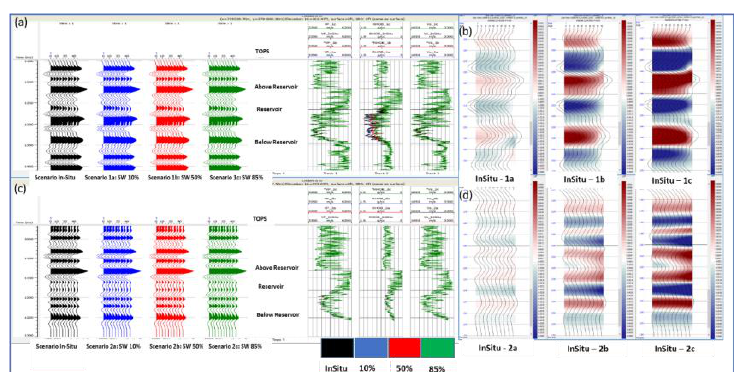
Figure 2. ( a ) Gas production well with different water saturation scenarios—angle of synthetic gath- ers with corresponding log tracks ( b ) Gas production well: angle stack of differences between in- situ and different SW ( c ) Water injection well with different water saturation scenarios—angle of synthetic gathers with corresponding log tracks, 4D difference of three water saturation scenarios and ( d ) water injection well: angle stack of differences between in-situ and different SW. The 4D effects were visible in the differences between the in-situ angle gather and the angle gather of the different scenarios of CO 2 gas displacement of the water in the